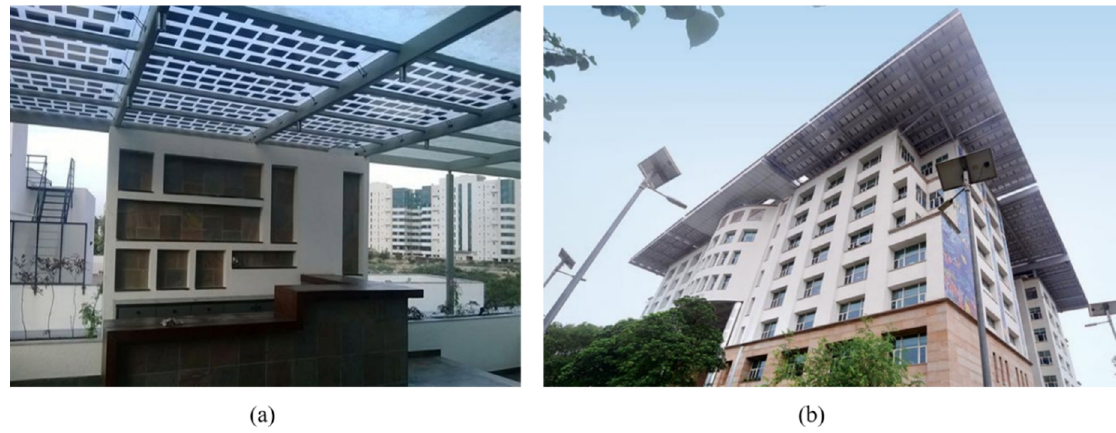
Figure 8. ( a ) Spaced type crystalline silicon solar-based BIPV roof for daylighting application (Source: HHV solar, Bangalore, India), ( b ) BAPV system in Indira Paryavaran Bhawan India (Image source: